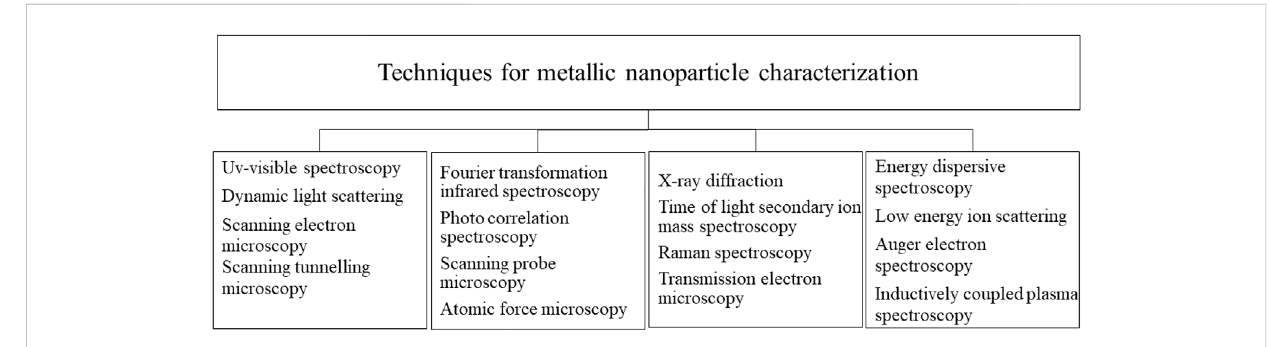
FIGURE 1 Various instrumental characterization techniques for MNPs.